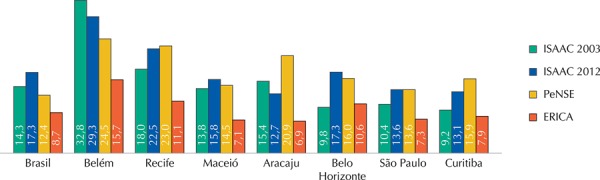
Prevalência (%) de diagnóstico médico de asma em adolescentes participantes do ISAAC fase III (2003-2012), PeNSE e ERICA.